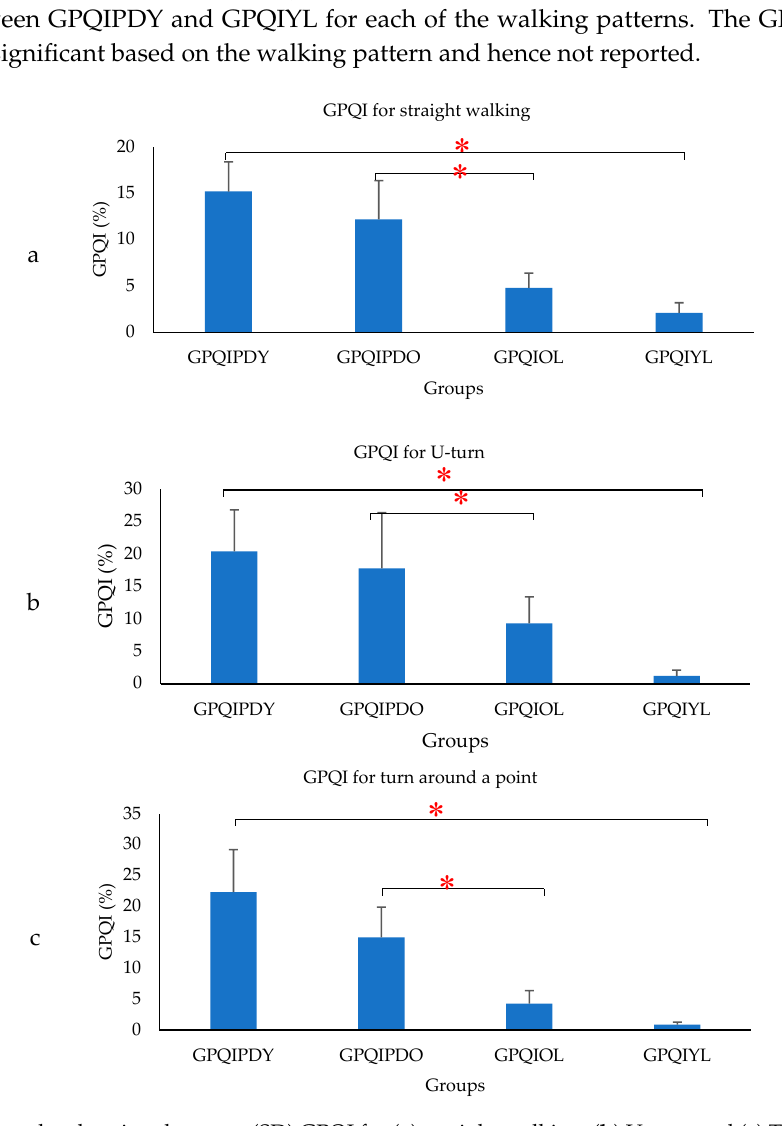
Figure 9. Bar plot showing the mean (SD) GPQI for ( a ) straight walking, ( b ) U-turn and ( c ) Turn around a point (* p (Significance) < 0.05).